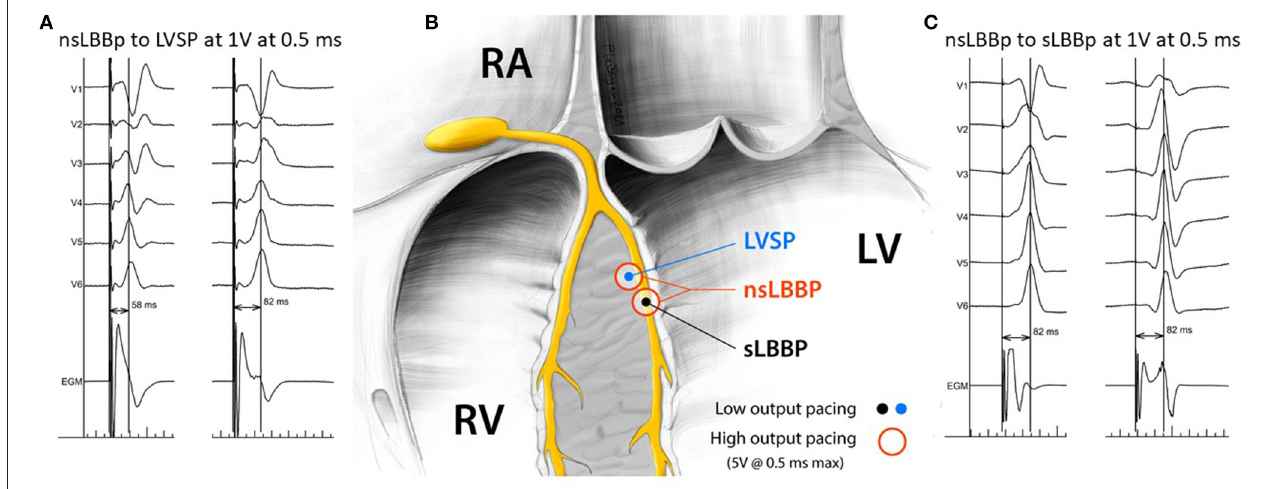
FIGURE 1 | Visualization of nsLBB to LVSP and nsLBBp to sLBBp transitions during pacing maneuvers (A,C) and representation of the position of the pacing lead tip in relation to the left Tawara branch for specified types of ventricular capture (B)